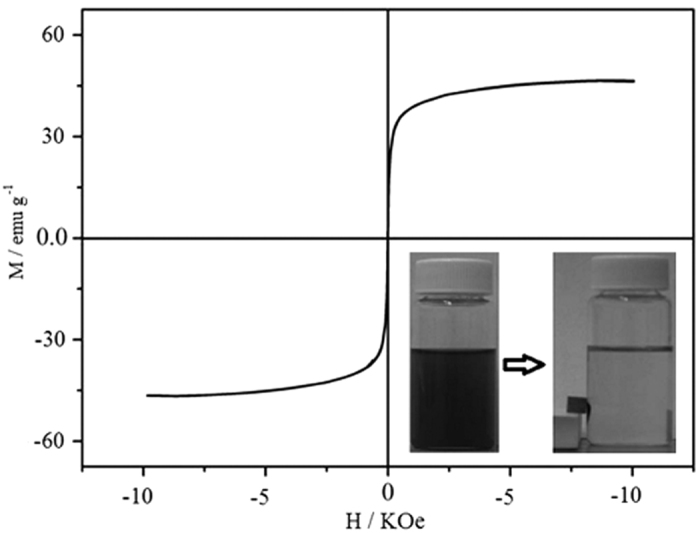
The magnetic hysteresis loop of hollow Fe3O4@NH2-MIL-101(Fe) magnetic products.